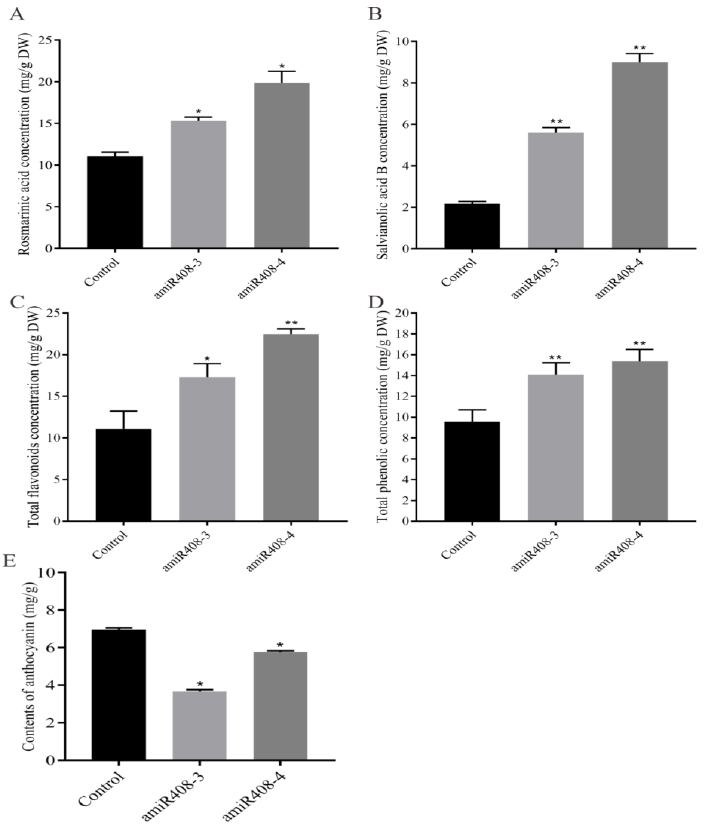
Figure 3. Detection of rosmarinic acid ( A ), salvianolic acid B ( B ), total flavonoids ( C ), total phenolic ( D ), and anthocyanin ( E ) content in transgenic (amiR408) and control lines. All data represent mean ± SD of three biological replicates. Significant differences in comparison with the control were assessed with Dunnett’s multiple comparison test (** p < 0.01; * p < 0.05).